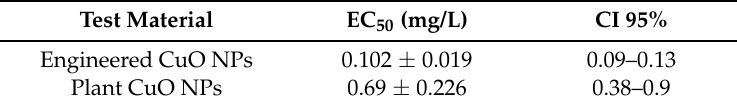
Table 2. EC 50 acute toxicity of engineered and plant CuO NPs.